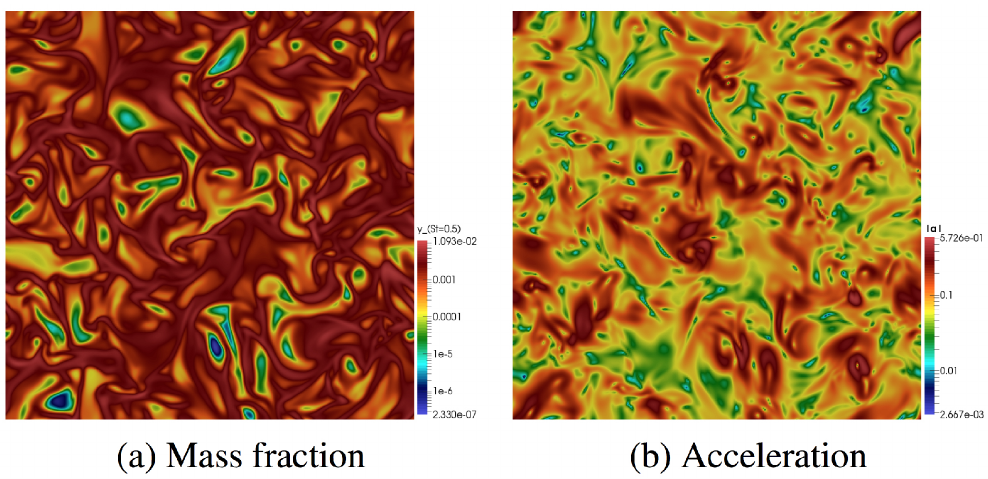
Figure 6. Slice of the turbulent box at t/τ e (cid:39) 2 . 2. The two panels represent respectively a logarithmic color map of y 3 ( St max = 0.5) and of | a g |